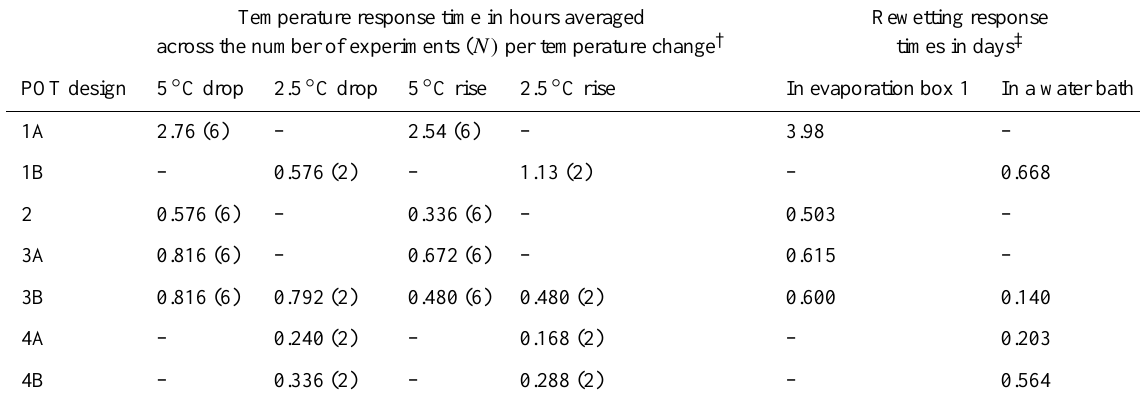
Table 3. Temperature and rewetting response times for the various POT designs. Temperature response time in hours averaged Rewetting response across the number of experiments ( N) per temperature change